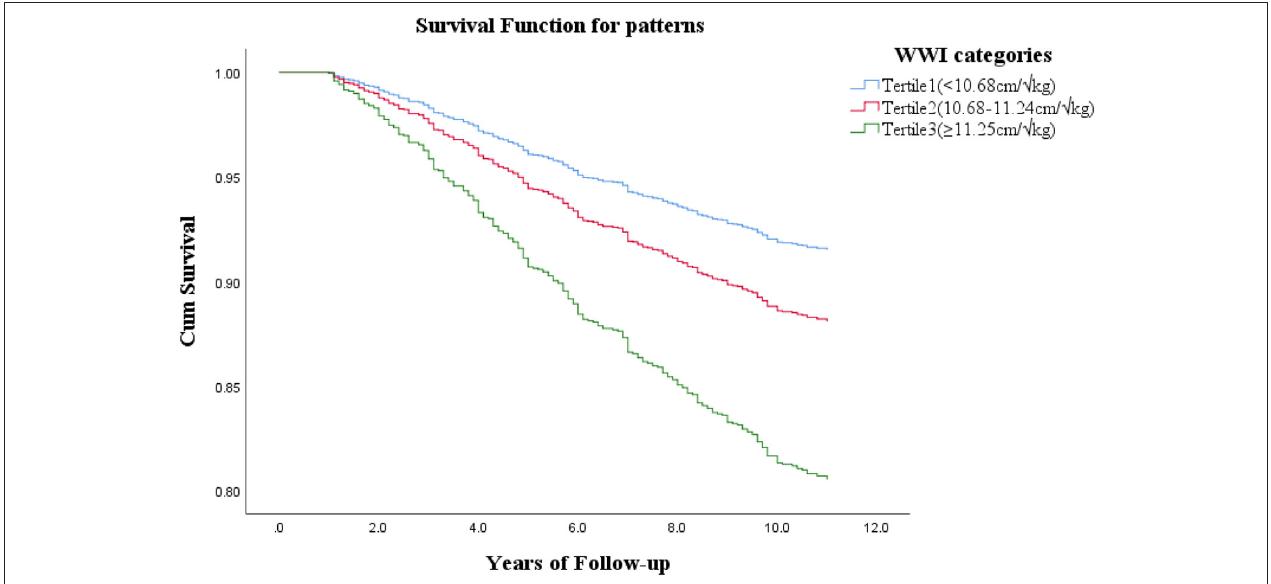
FIGURE 1 | Cox proportional hazards after adjusted for age, sex, BMI, WC, SBP, DBP, FPG, TC, HDL, LDL, TG, SUA, SCr, smoking, alcohol drinking, CHD, HTN, diabetes, stroke.